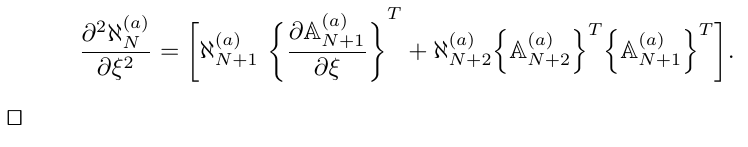
Algorithm 1. Meixner pole